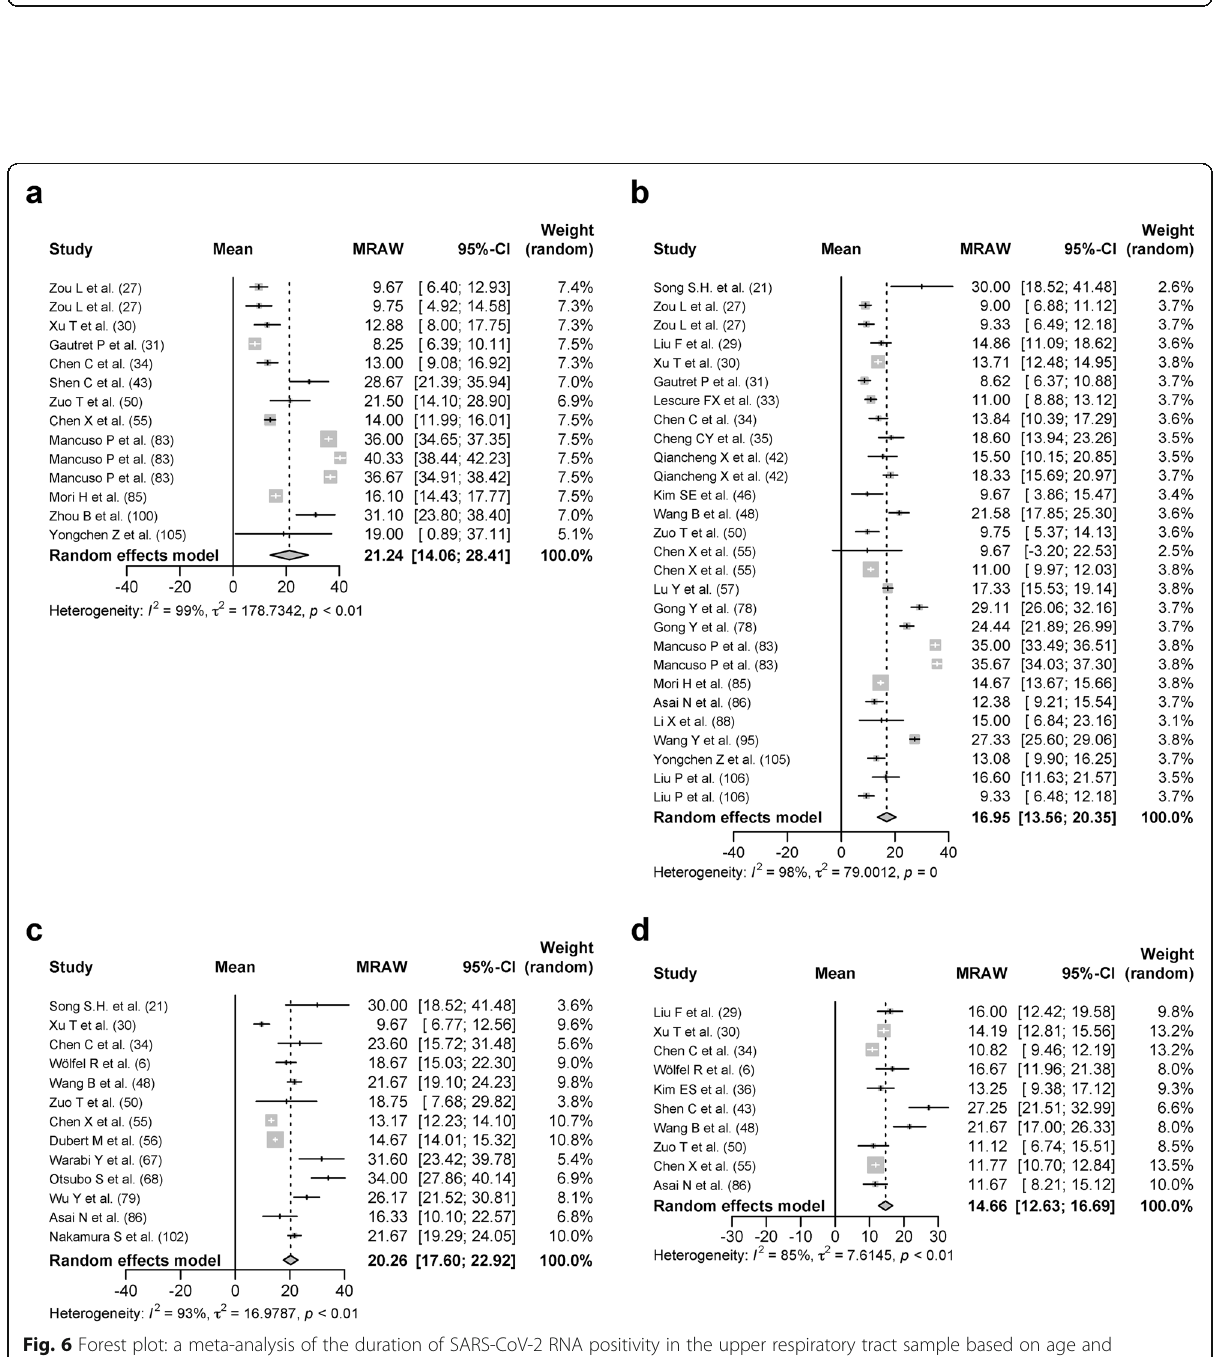
Fig. 6 Forest plot: a meta-analysis of the duration of SARS-CoV-2 RNA positivity in the upper respiratory tract sample based on age and comorbidities. The duration of SARS-CoV-2 RNA positivity from the onset of COVID-19 in the patients over the age of 60 ( a ), patients under the age of 60 ( b ), patients with any comorbidities ( c ), patients without any comorbidities patients ( d ) was calculated using the random effects model. MRAW, the raw data of mean; 95%-CI, 95% confidence